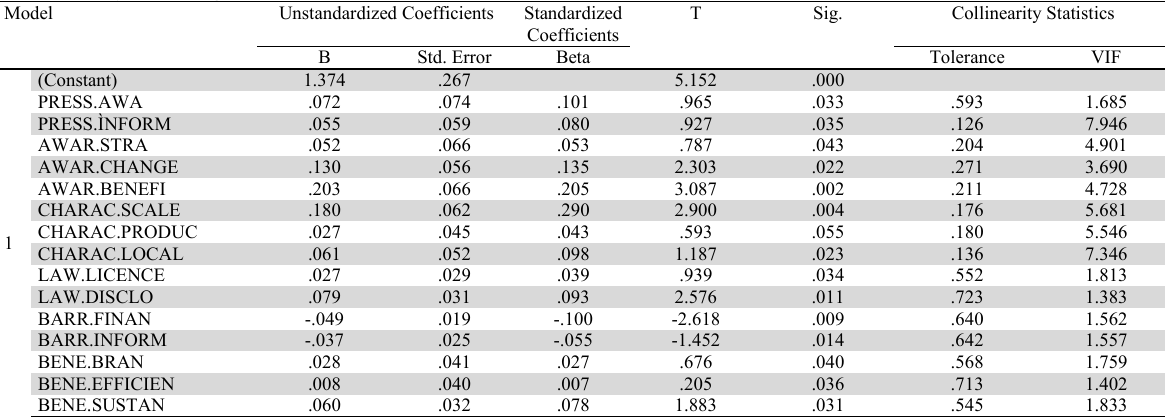
The summary of the regression estimate